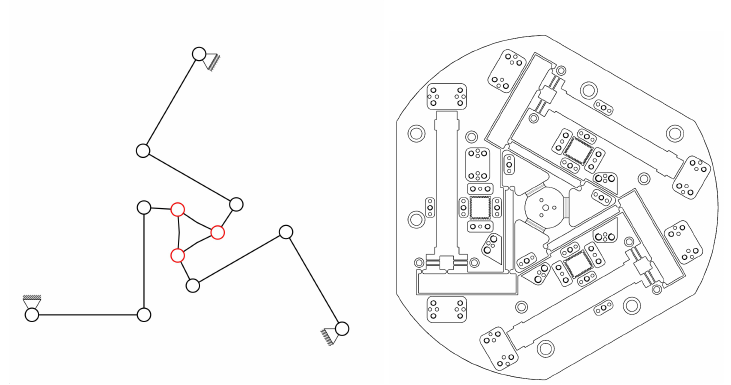
Figure 4. Upper sub-structure of the two-in-one structure.